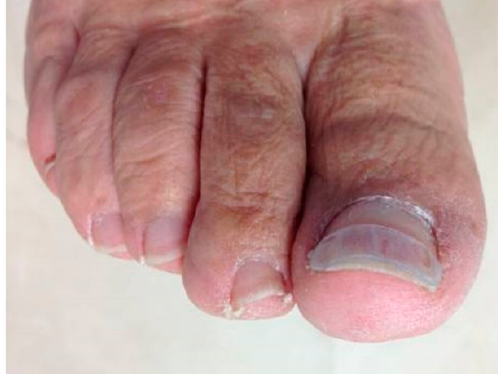
Figure 1. Strip of polyethylene treatment in ingrown toenails.